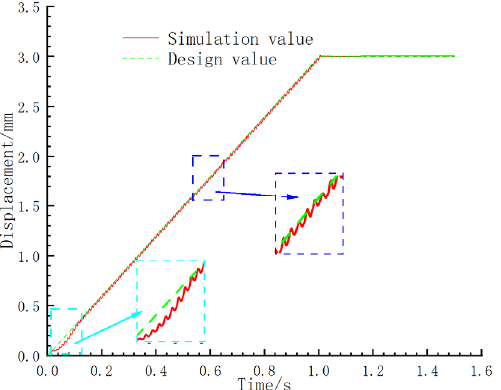
Figure 18. Displacement response curve of propulsion cylinder.